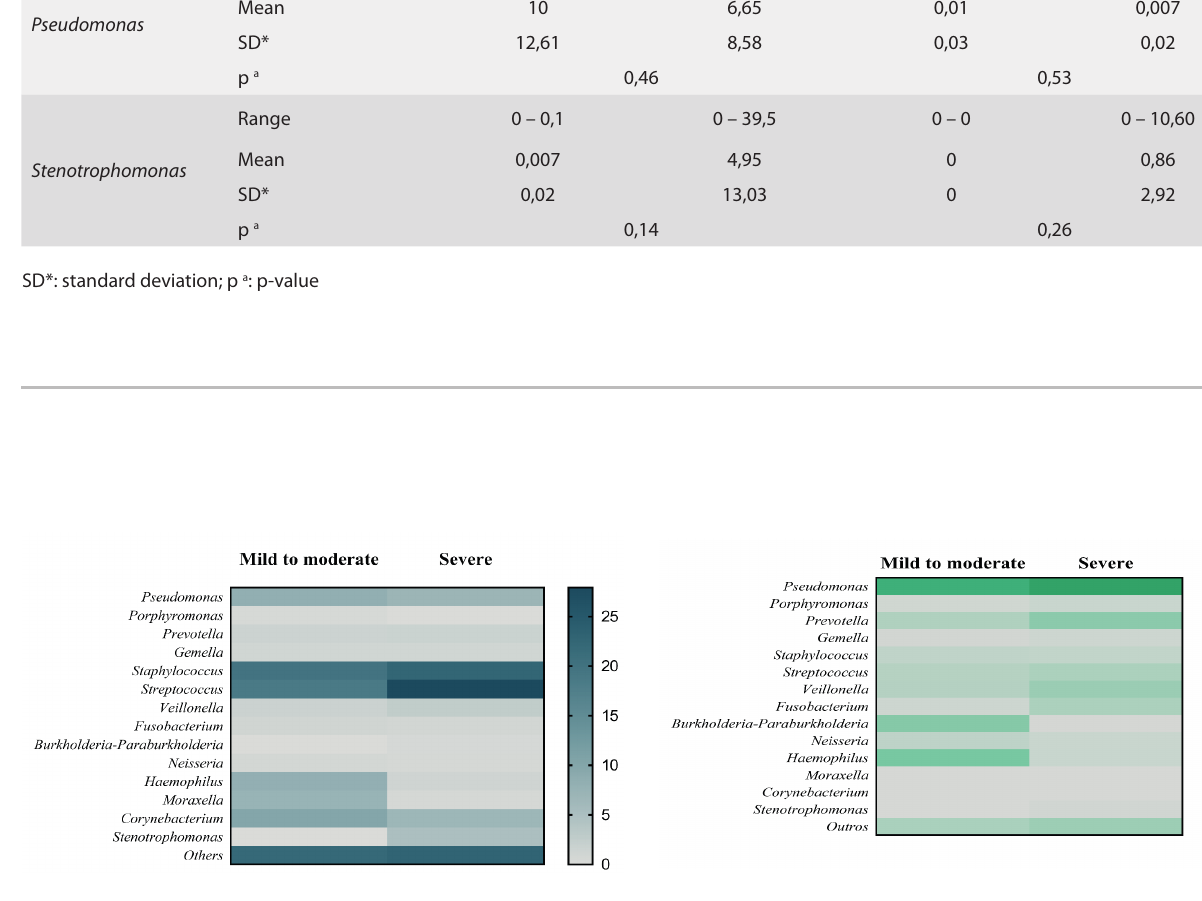
Figure S2. Heat map of bacterial genera in sputum according to lung dis- ease severity. Patients with severe lung disease had a higher proportion of Pseudomonas , Prevotella , Streptococcus and Veillonella and a smaller proportion of Haemophilus , Neisseria and Burkholderia-Paraburkholderia compared to those with mild/moderate